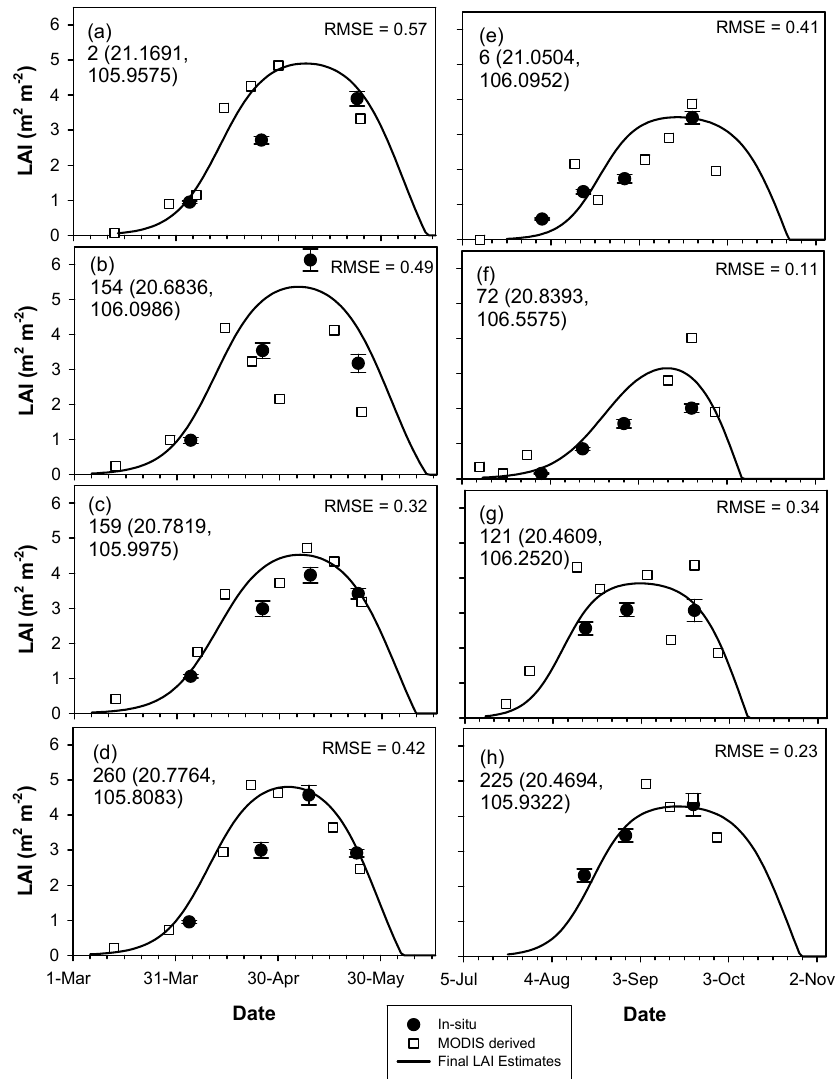
Figure 3. Estimated LAI using MODIS and the Radiative Transfer Model and as well combined with the double logistic model against ground-based LAI for selected study locations (location ID and geo-coordinates are shown in the upper right corner of each panel) during the 2016: spring ( a – d ); and summer ( e – h ) seasons in the Red River Delta of Vietnam.